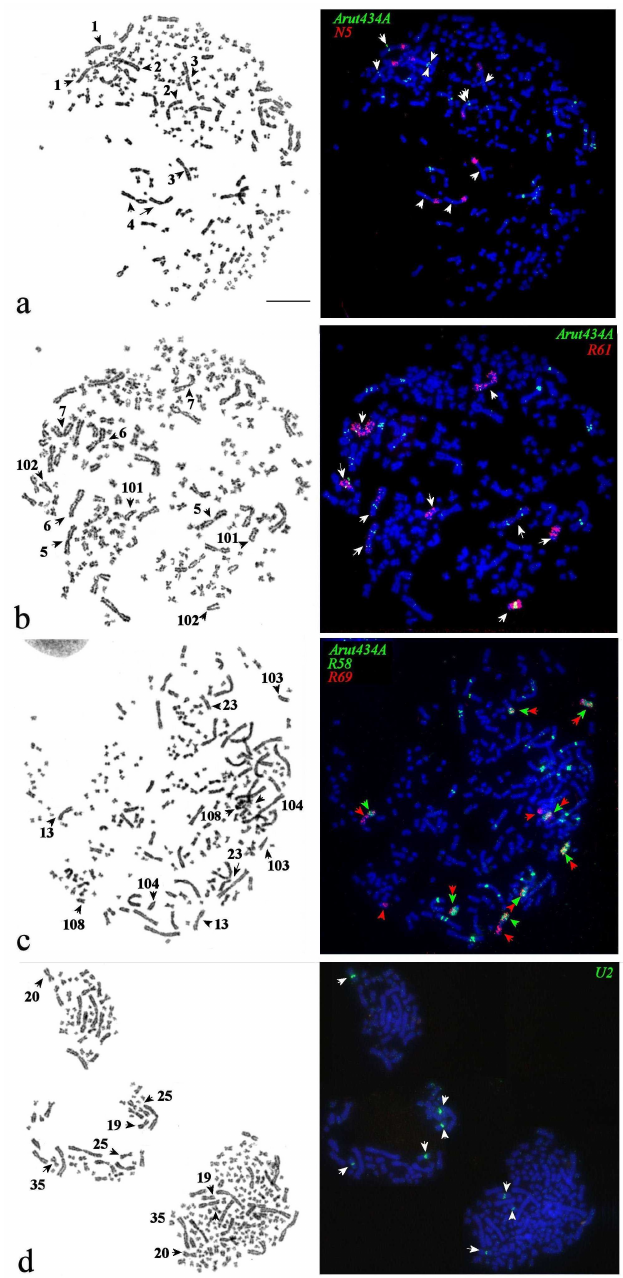
Figure 6. FISH of repetitive and microdissection-derived painting probes ( right ) on GTG-banded metaphase plates ( left ) of the Siberian sturgeon ( a – d ). ( a ) Arut434A (green) and microdissection-derived painting probe N5 (red) for ARUT 1p and 2p colocalized on ABAE 1–4; ( b ) Arut434A (green) and microdissection-derived painting probe R61 (red) for ARUT 4 colocalized on ABAE 7, 101, and 102, sometimes very weakly marked ABAE 5 and 6, orthologs of ARUT 3; ( c ) Arut434A (green) and microdissection-derived painting probes R69 (red) for orthologs of the ARUT 7 (ABAE 13, 23, and 108) and ARUT 14 (ABAE 103 and 104), and R58 (green) for orthologs of ARUT 7q (ABAE13 and 23)and ARUT 14. ( d ) U2 (green) localized into chromosomes 19, 20, 25, and 35. Arrows marked chromosomes with signals. The scale bar is 10 µ m.